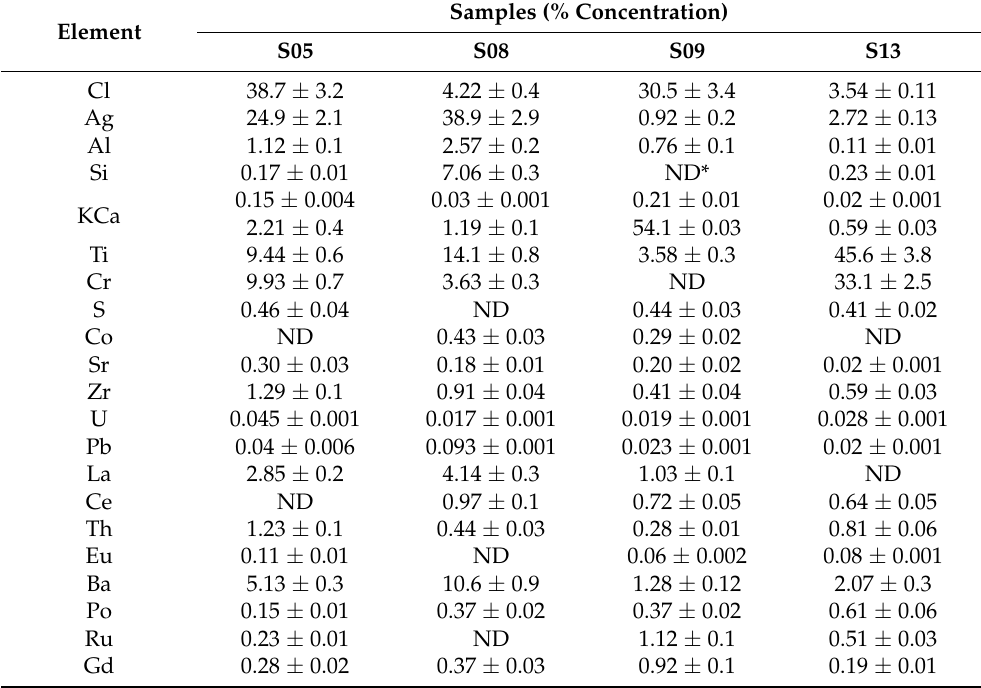
Table 2. Elemental composition of the